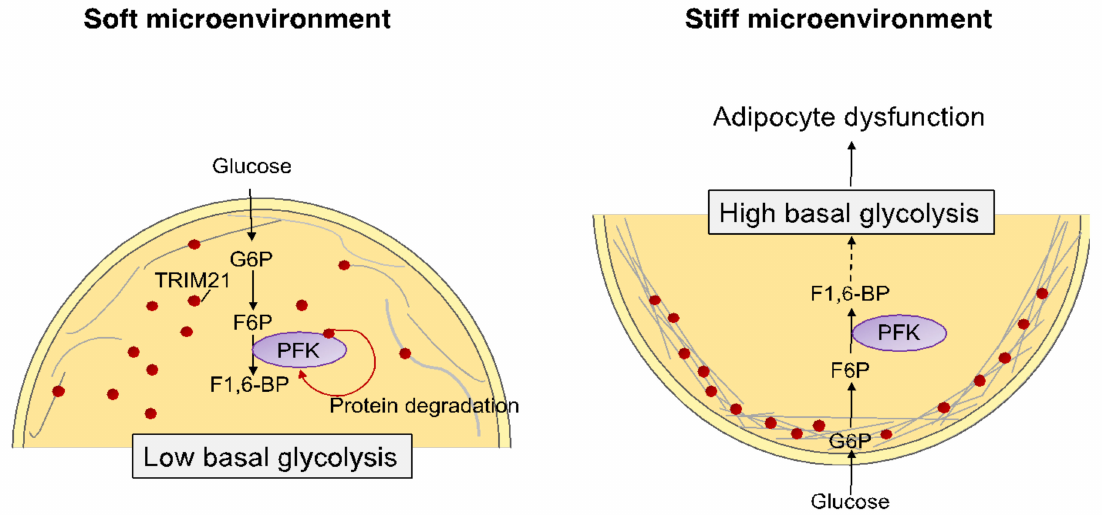
Figure 3. Hypothetical mechanical regulation of metabolism. Recent studies revealed that me- chanical forces altered cell metabolism via cytoskeletal reorganization in cancer cells [194]. In a soft microenvironment, TRIM21 was not trapped by actin stress fiber bundles, which degrade phospho- fructokinase (PFK). This led to low glycolysis rates. By contrast, when cells were surrounded by a stiff microenvironment (as in obese adipose tissue), TRIM21 was bound to the F-actin bundles of the cytoskeleton and thus PFK degradation was prevented, leading to high rates of glycolysis. By these mechanisms, we believe that mechanical cues could influence the metabolic phenotype and progression of adipose tissue